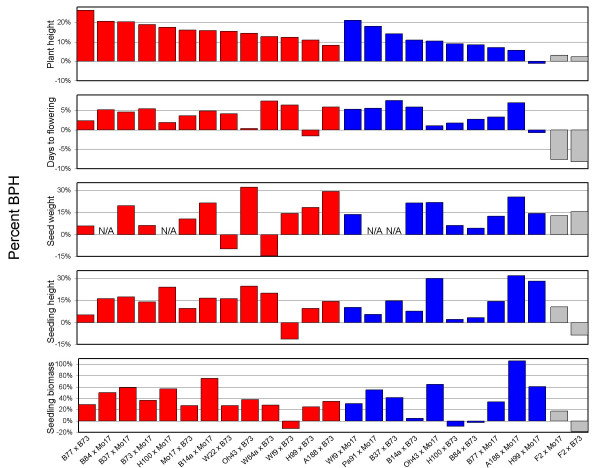
Heterosis for non-yield traits. The percent BPH is shown for all traits and all hybrids scored in this study. The numerical BPH values are available in Additional file 2. Red bars represent BPH for hybrids generated between SS and NSS inbreds, blue bars represent BPH for hybrids generated within SS and NSS inbreds, and grey bars represent BPH for hybrids derived from an inbred line with mixed origin (F2).